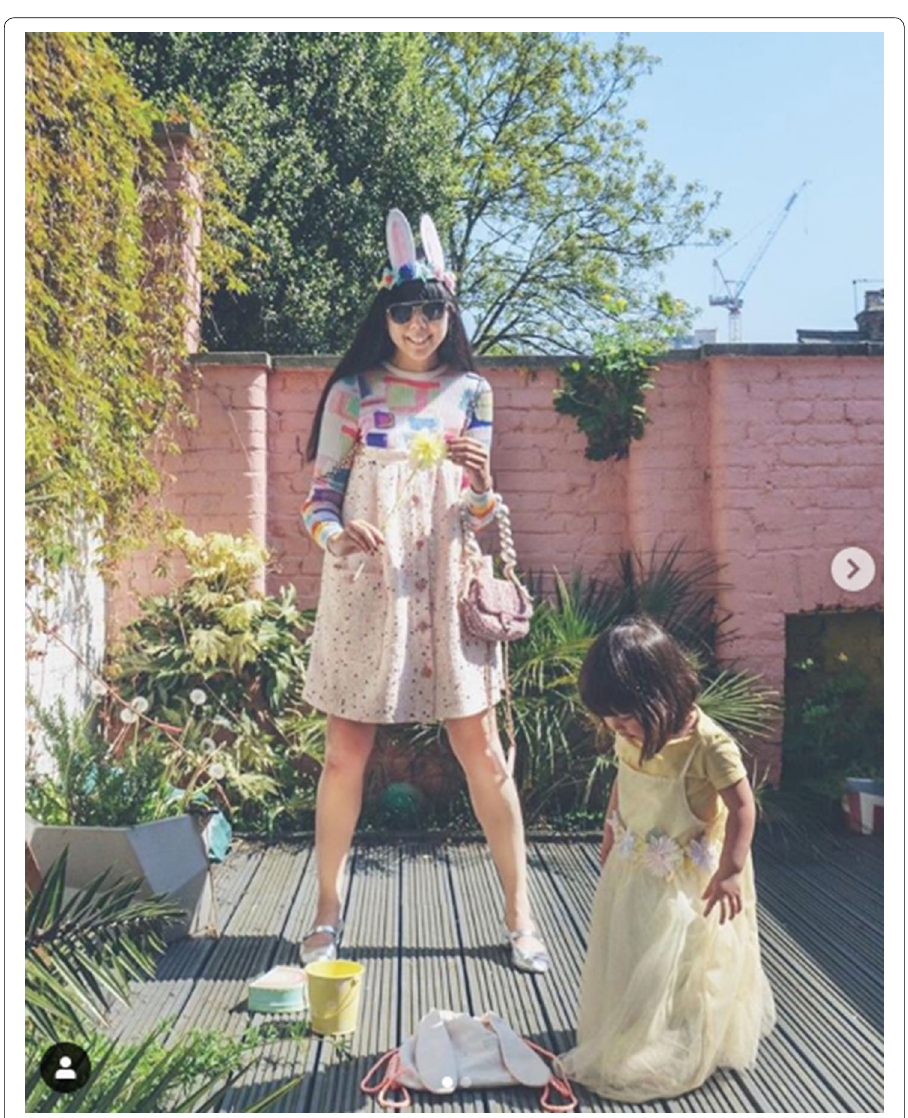
Fig. 8 Chanelofficial outfit Esterfied with merimeriparty. https ://www.insta gram.com/p/Bwh7y -4H2uS /. Accessed 20 September